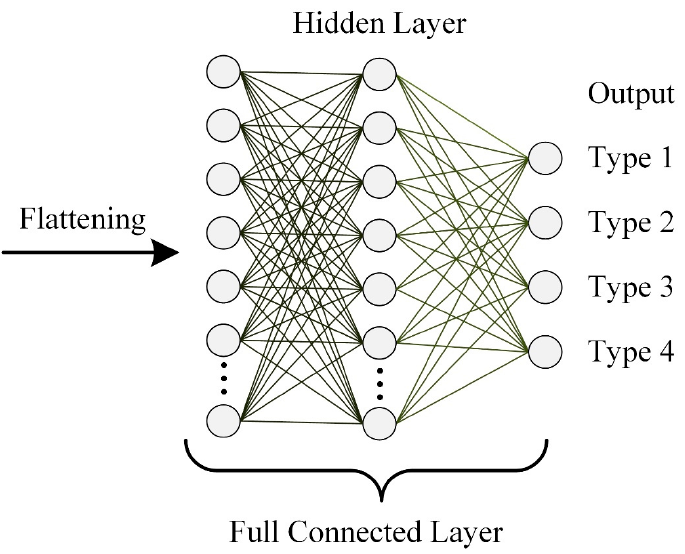
Figure 14. Model architecture for fully connected layer.